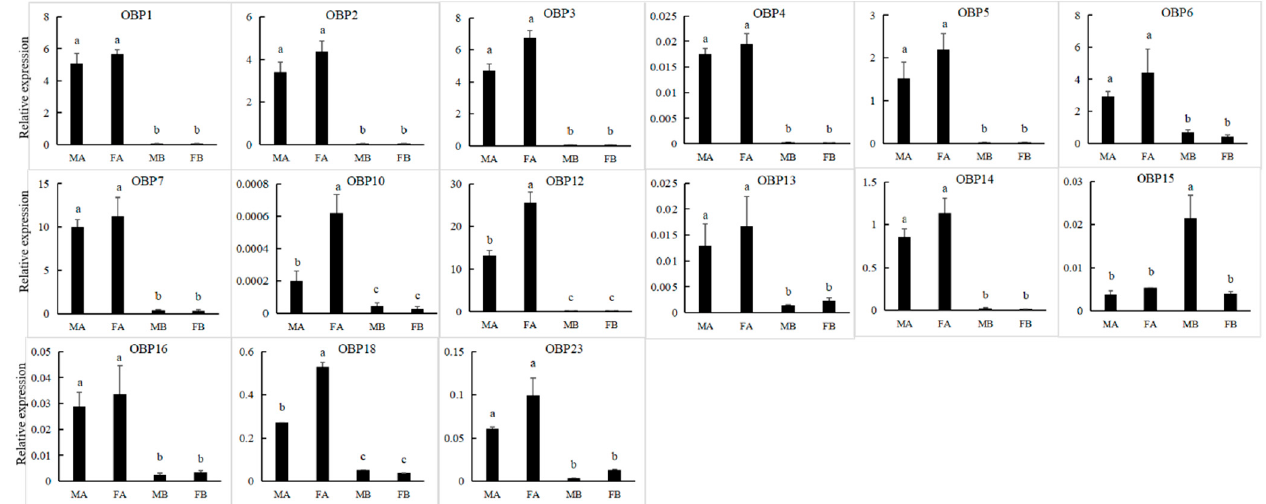
Figure 4. Expression levels of PverOBP genes in different tissues assessed by RT-qPCR. MA, male antennae; FA, female antennae; MB, male body (without antennae); FB, female body (without antennae). Error bars, r, are represented by the standard error of three biological replicates. Different letters (a–c) indicate significant differences ( p < 0.05) of male or female based on one-way ANOVA.